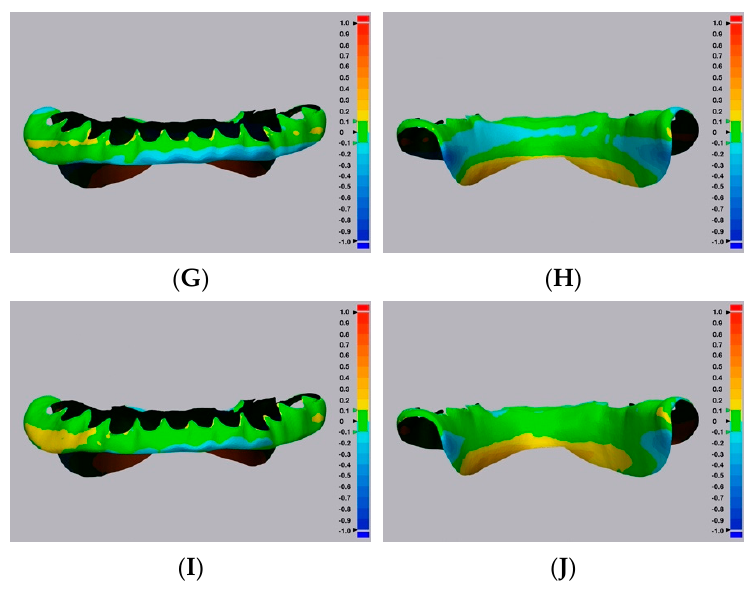
Figure 5. Representative surface matching color maps from the five study groups, across cameo denture extension portion. ( A , B ) Group 1—conventional technique. ( C , D ) Digital—CBCT—DLP 3D printer. ( E , F ) Digital—CBCT—SLA 3D printer. ( G , H ) Digital—Laboratory Scanner—DLP 3D printer. ( I , J ) Digital—Laboratory Scanner—SLA 3D printer.